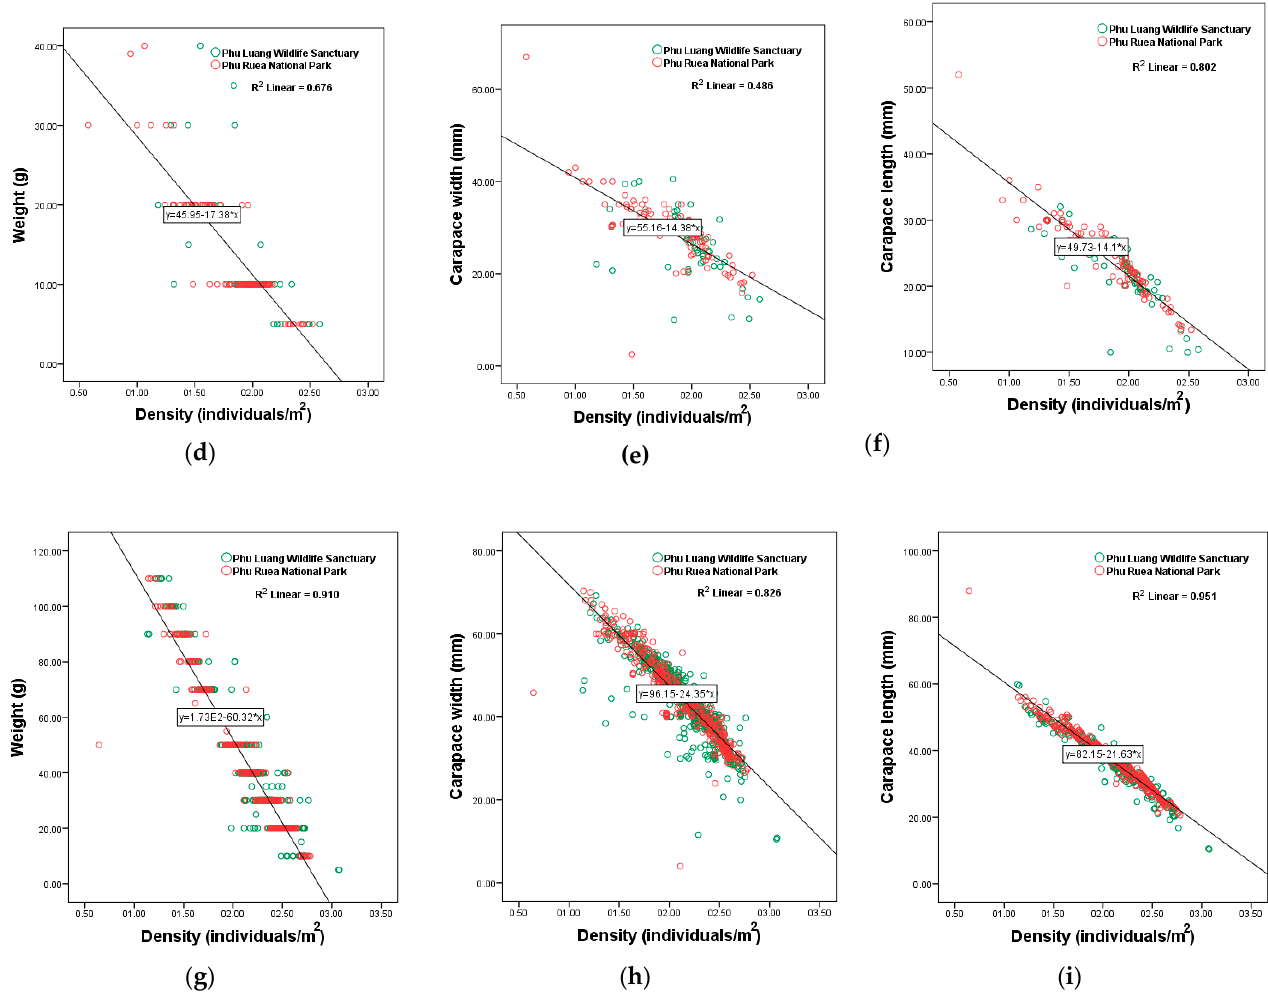
Figure 8. Association between density and body size: weight ( a ); carapace width ( b ); and carapace length ( c ); juvenile weight ( d ); juvenile carapace width ( e ); juvenile carapace length ( f ); adult weight ( g ); adult carapace width ( h ); adult carapace length ( i ) of I. bhumibol in Phu Luang Wildlife Sanctuary and Phu Ruea National